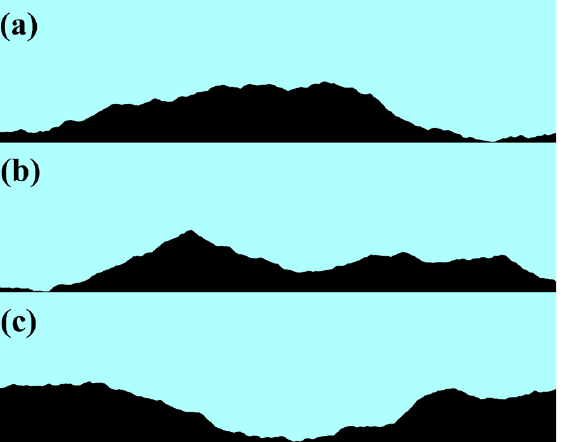
Figure 12. Different solid walls with the same fractal dimension: ( a ) solid wall a, ( b ) solid wall b, and ( c ) solid wall c.